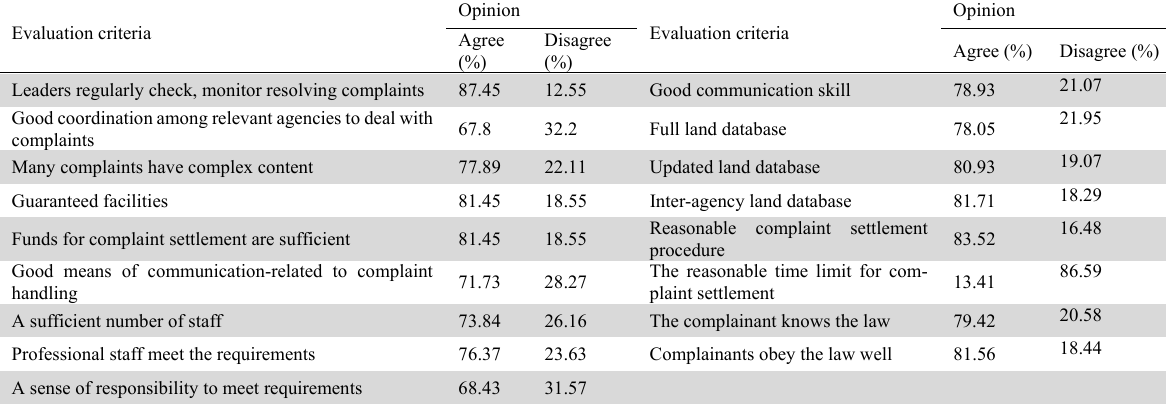
Evaluation of the implementation of complaint settlement when the State acquires land in Bac Ninh city. Evaluation criteria